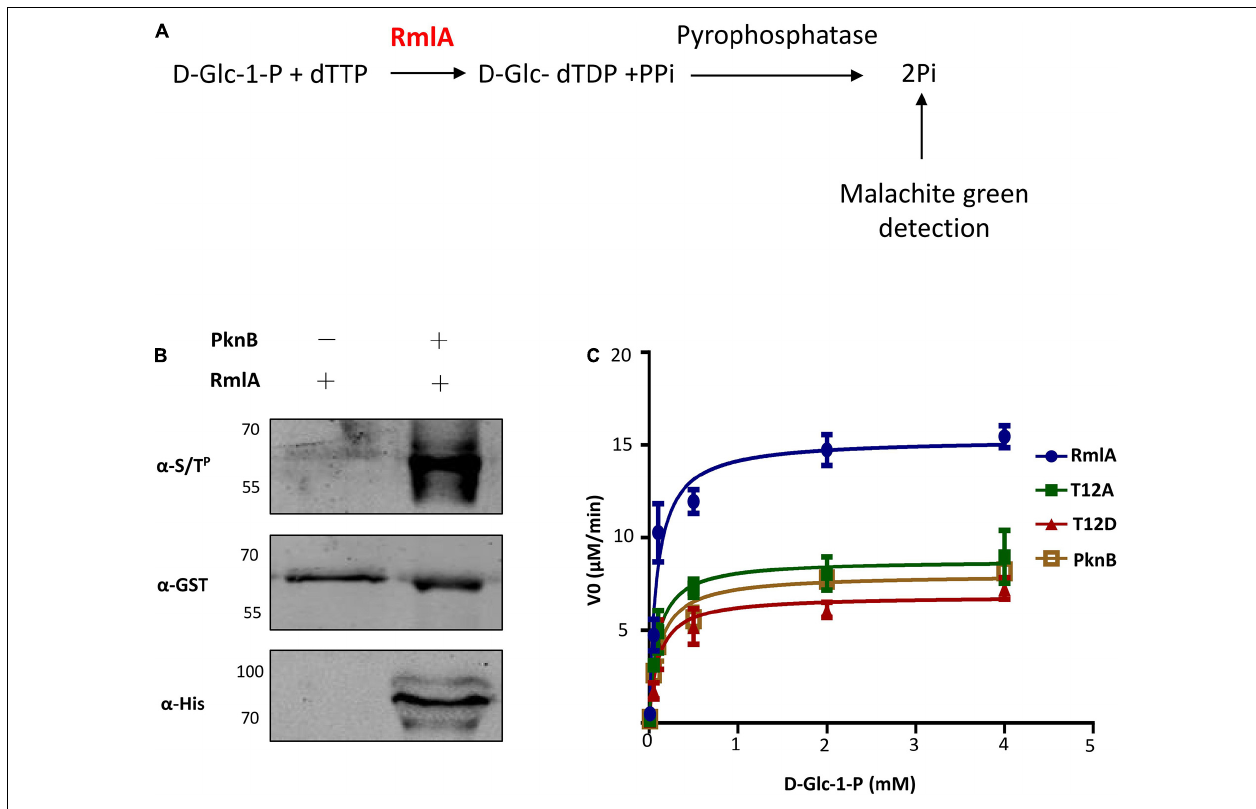
FIGURE 4 | T12 of RmlA is a key residue for activity. (A) Schematic depicting the biochemical reaction catalyzed by RmlA. (B) Phosphorylation detecting with RmlA by PknB coexpression. (C) The activities of RmlA, RmlA-PknB coexpression, and its T12 mutants were determined based on Michaelis–Menten kinetics, representative of three. Five micrograms of purified RmlA protein was added to the 50 µ L of enzyme reaction buffer [50 mM Tris (pH 7.5), 1 mM dithiothreitol, 5 mM MgCl 2 , 0.2 mM dTTP, and 1 mM D -Glc-1-P] and incubation at 37 ◦ C for 1